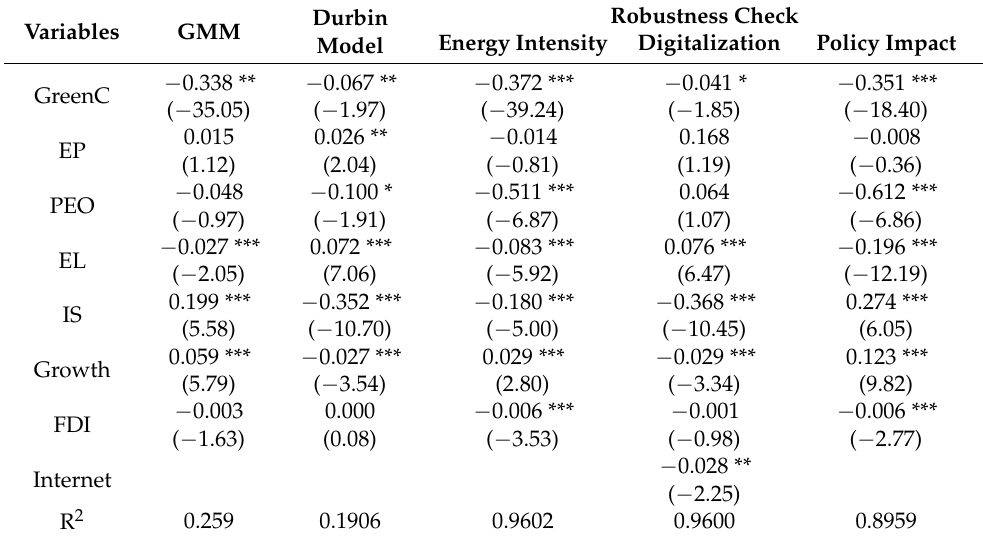
Table 7. Regression results for